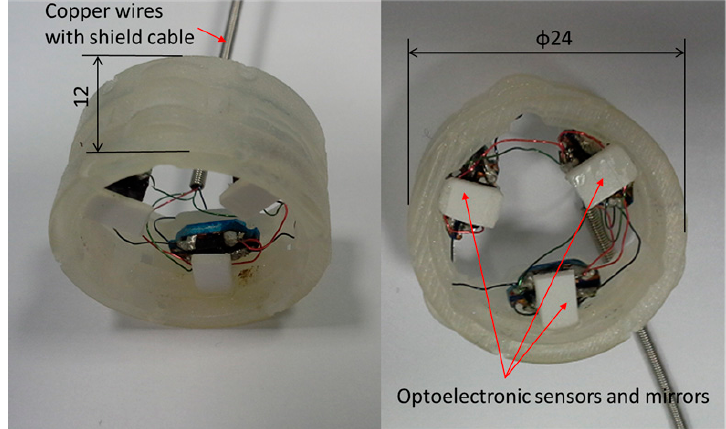
Figure 2. Fabricated three-axis force/torque sensor.